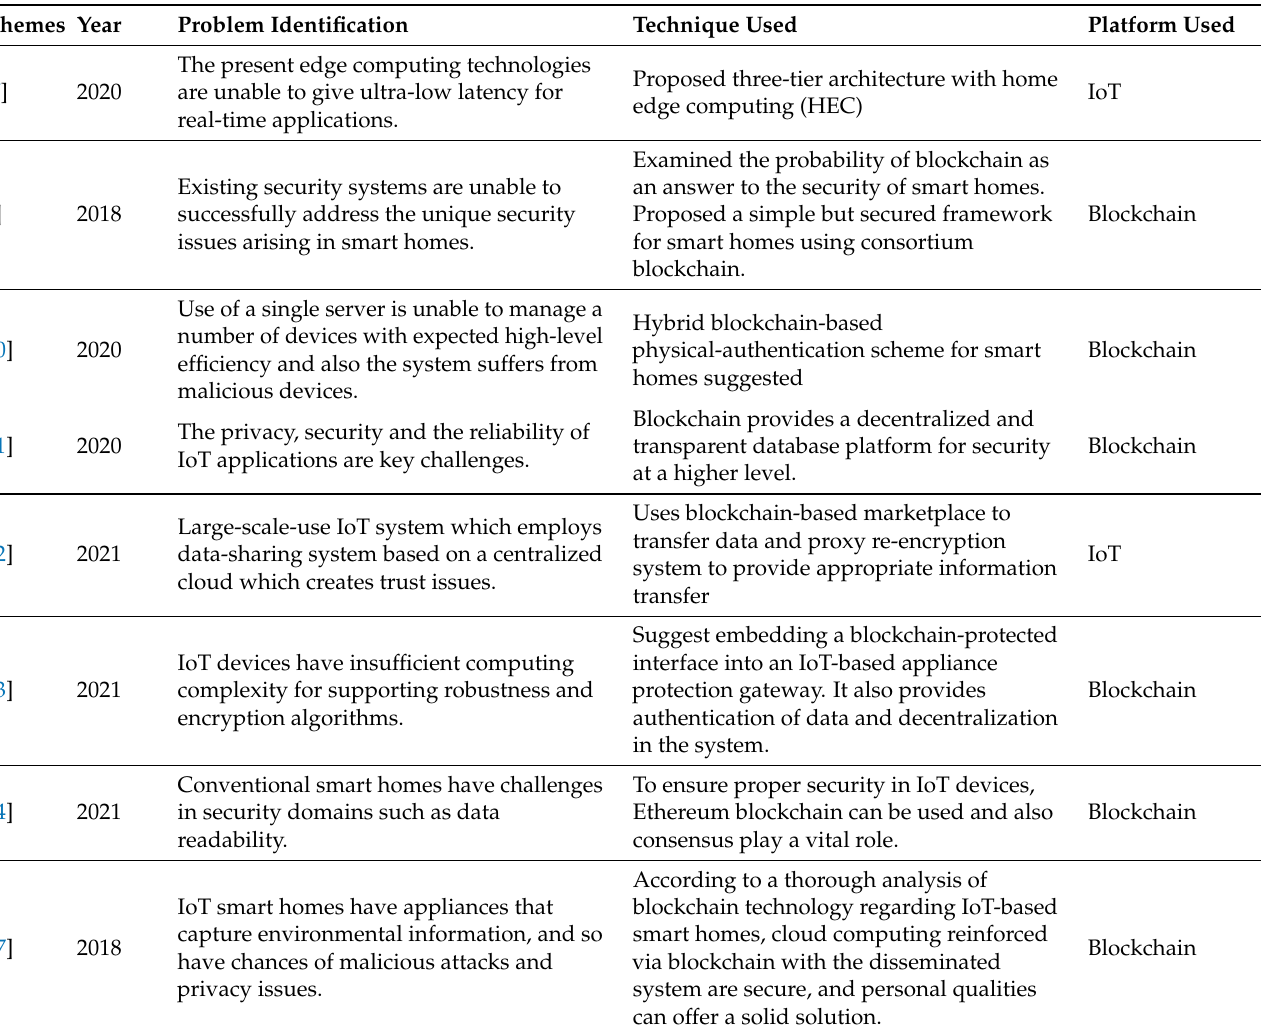
Table 2. Comparison of various schemes using blockchain-based security with different